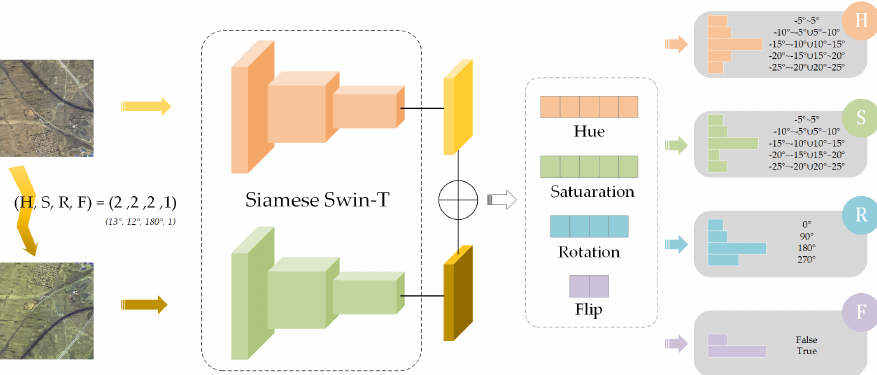
Figure 4. The schematic diagram of the duel-stream self-supervised